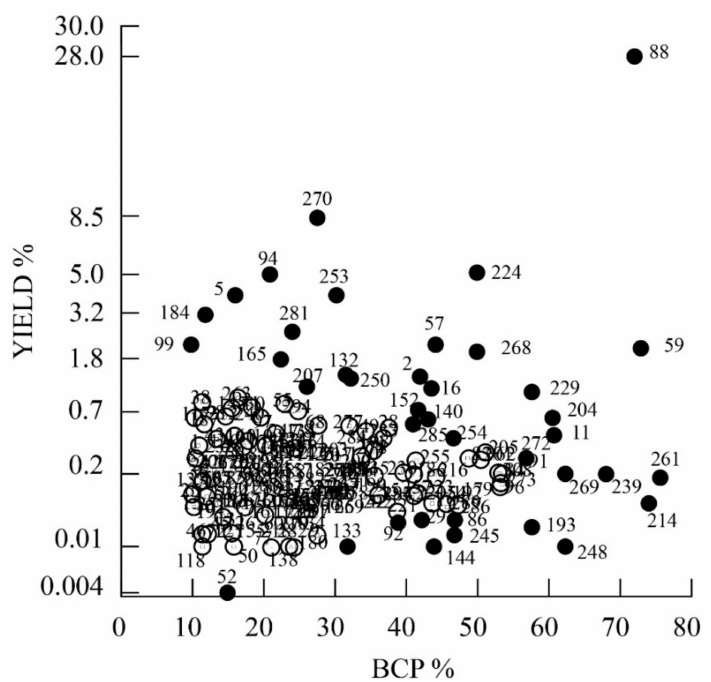
Figure 1. Scatter plot of BCP percentage vs. yield percentage. The yield axis is represented as a power of 0.3 scale in order to evidence species with yields ranging from 0.004 to 3%. Numbers correspond to plant species listed in Table 1. Filled circles outline the species outside the central group of all other species (hollow circles).